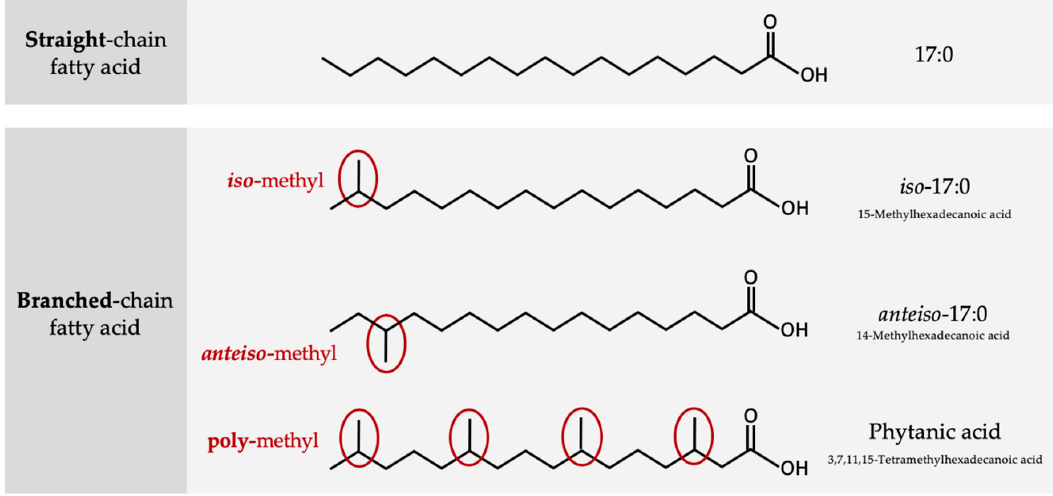
Figure 1. Structural differences between straight chain fatty acids and iso ‐ , anteiso ‐ , and multimethyl branched ‐ chain fatty acids.